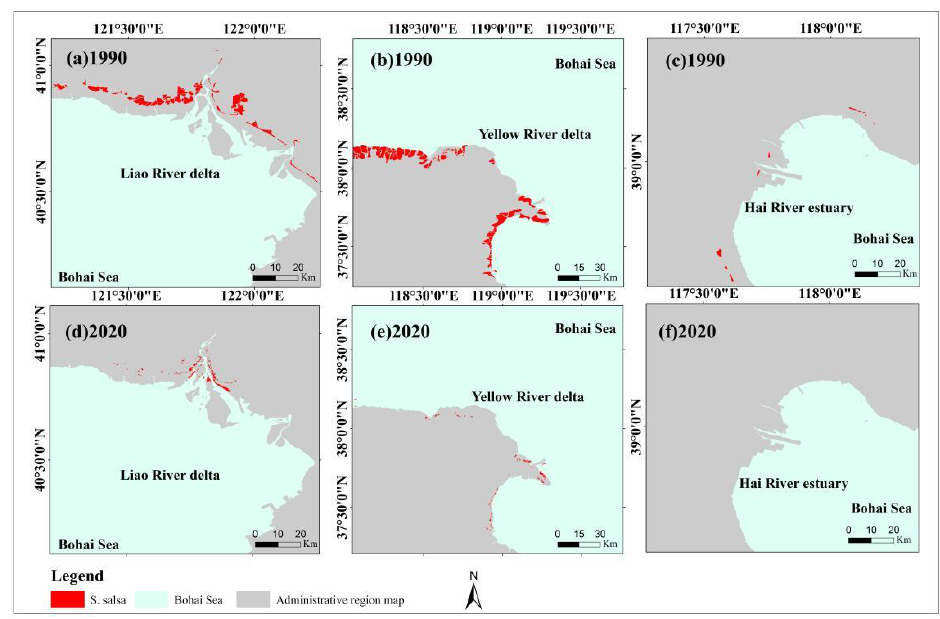
Figure 6. The administrative region map in the 1990s and S. salsa areas in Bohai Bay in 1990 and 2020: ( a ) Liao River Delta in 1990, ( b ) Yellow River Delta in 1990, ( c ) Hai River Estuary in 1990, ( d ) Liao River Delta in 2020, ( e ) Yellow River Delta in 2020, and ( f ) Hai River Estuary in 2020.